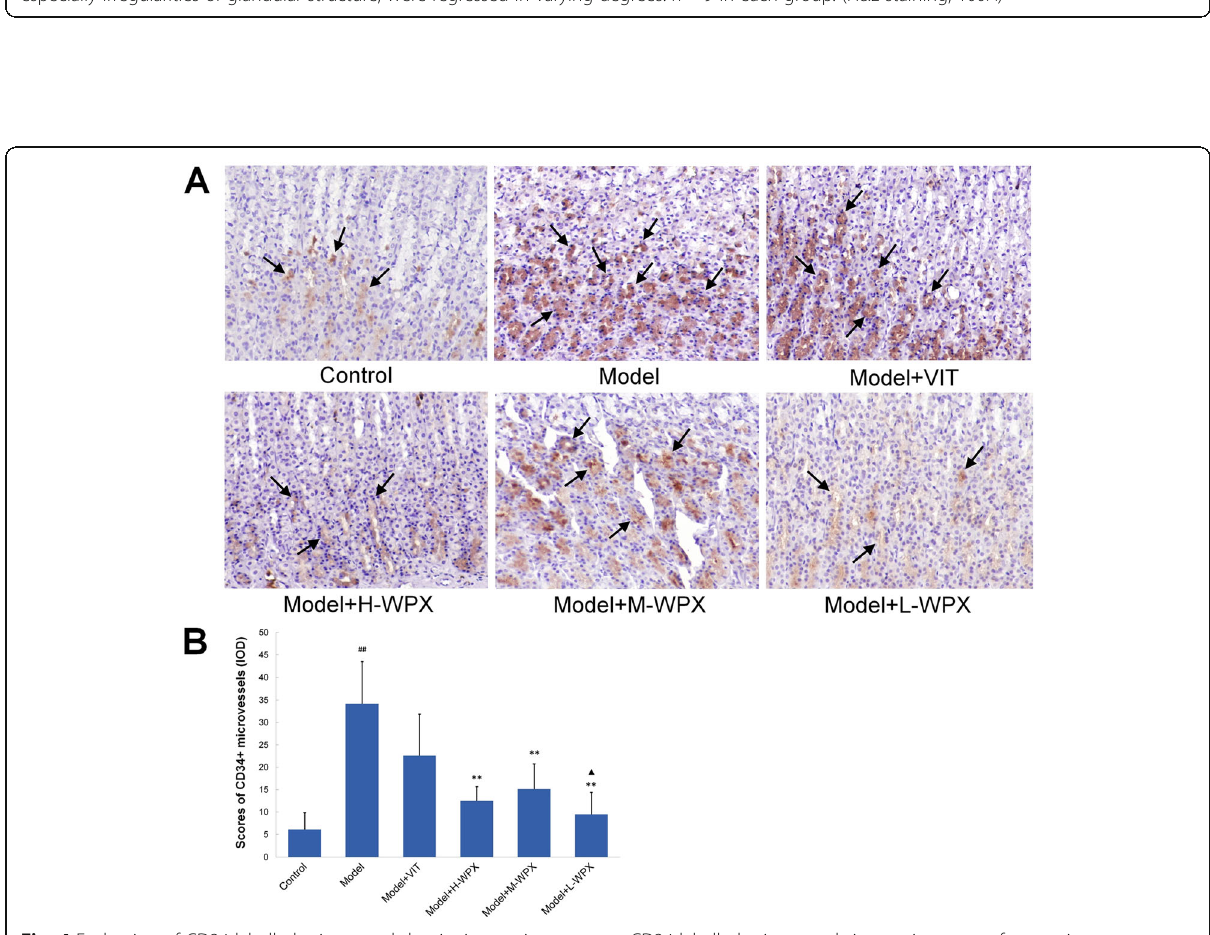
Fig. 4 Evaluation of CD34-labelled microvessel density in gastric mucosa. a CD34-labelled microvessels in gastric mucosa from various groups. Some representative microvessels are indicated by black arrows. b Scores of CD34+ MVD levels. The results are expressed as mean ± SD ( n = 9 in each group). Note: ## P < 0.01, vs Control; ** P < 0.01, vs Model; ▲ P < 0.05, vs VIT. (IHC,